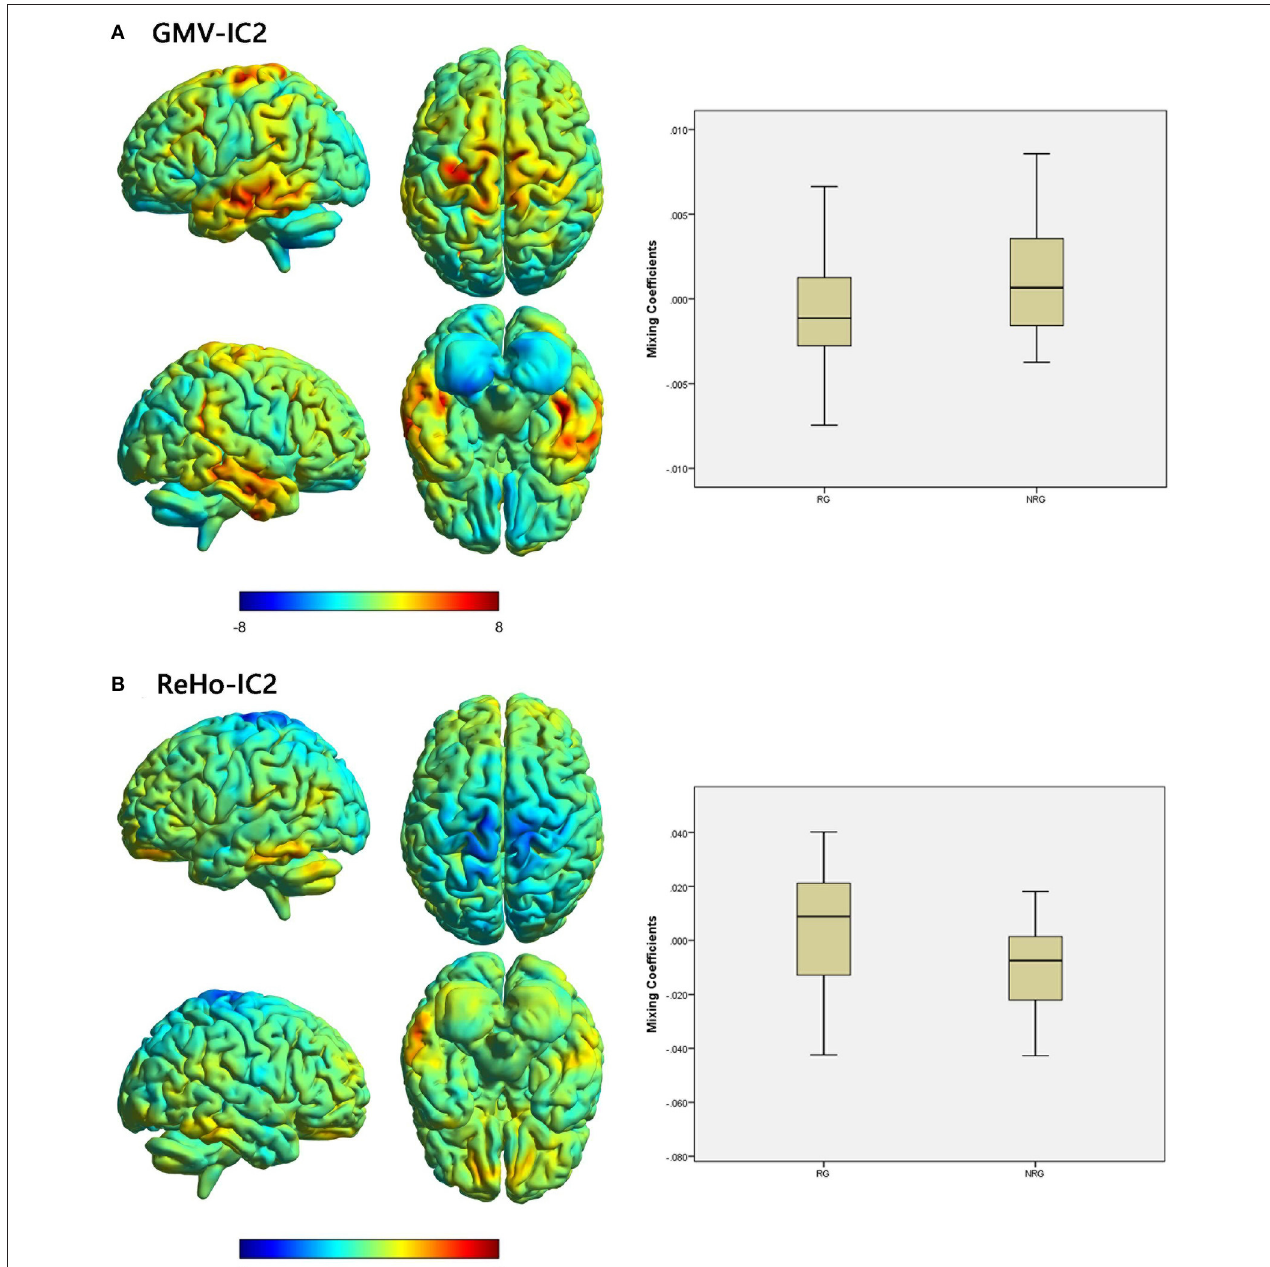
FIGURE 2 | Brain maps of shared discriminative IC and box plots of mixing coefficients between the RG and NRG. The left part of the figure is the brain map, and the right part is the mixing coefficient box plot (outliers have been excluded). The color bar represents the Z-scores. Box plots show that the RG has lower mixing coefficients than the NRG for GMV-IC2 (A) and higher mixing coefficients than the NRG for ReHo-IC2 (B) . When z values (red regions) are positive and mixing coefficients are positive, the component shows increased GMV/ReHo in the NRG. Conversely, when z values are negative (blue regions) and mixing coefficients are positive, the component shows decreased GMV/ReHo in the NRG. The opposite is true when mixing coefficients are negative. RG, responder group; NRG, non-responder group; IC, independent component; GMV, gray matter volume; ReHo, regional